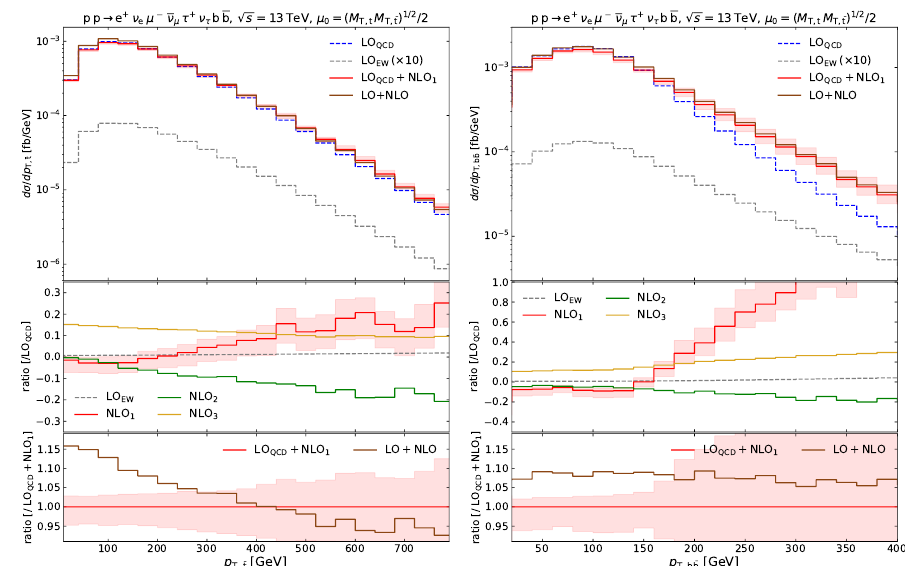
Figure 7: Distributions in the transverse momentum of the antitop quark (left) and of the two-b-jet system (right). Same structure as Fig.